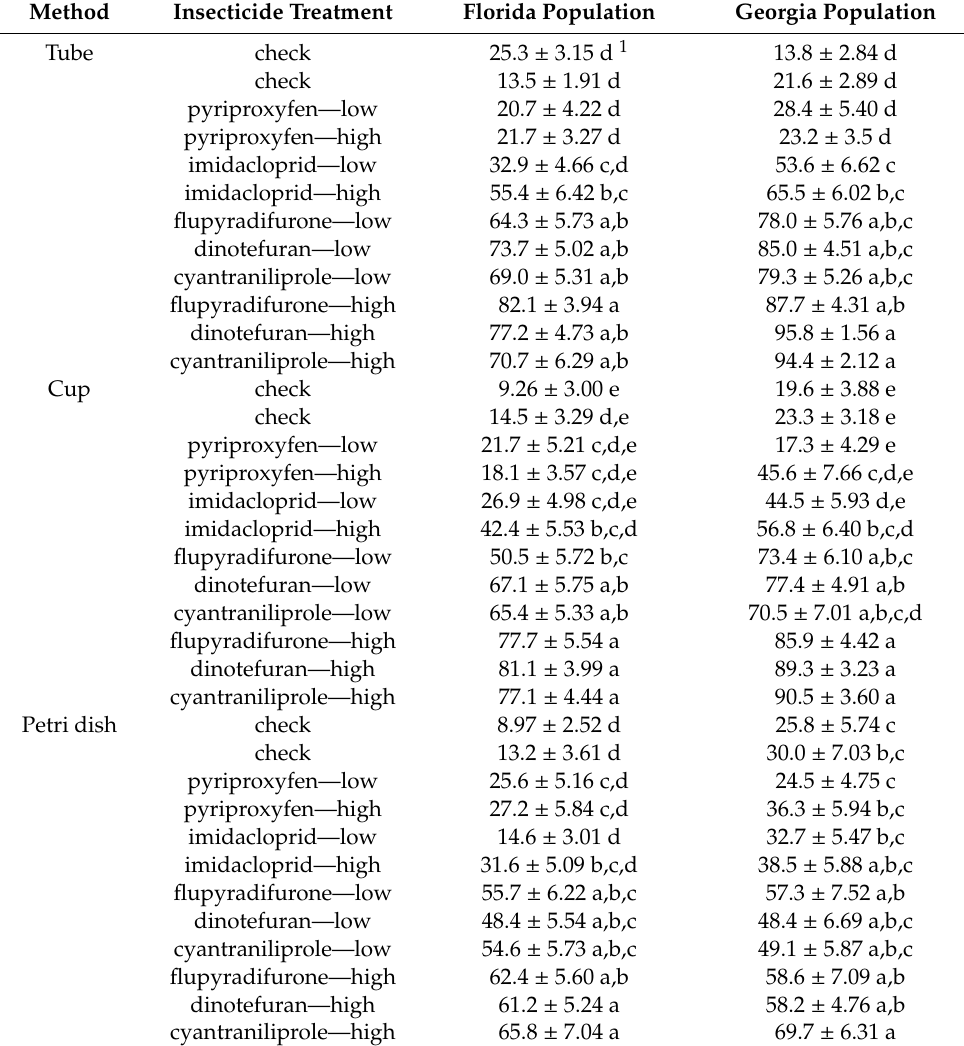
Table 4. Percent adult mortality of the Florida and Georgia whitefly populations across insecticide treatments by tube, cup, petri dish, and clip cage bioassay methods, respectively, Tifton, GA, USA,